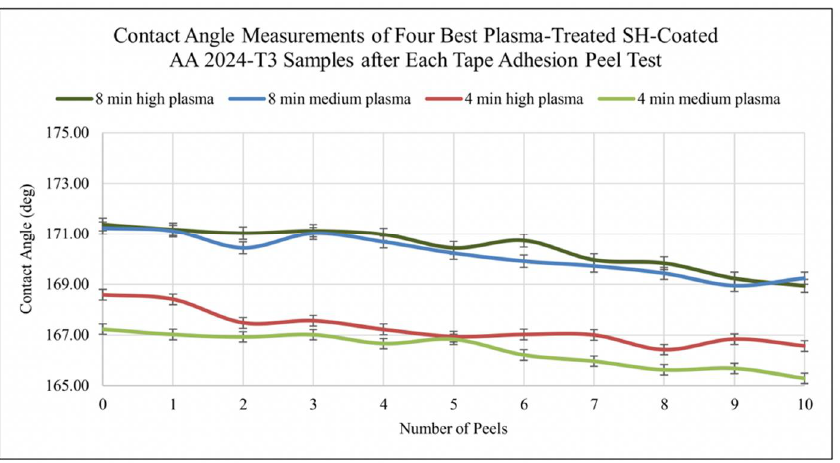
Figure 8. The contact angle after tape adhesion peel test. Reprinted with permission from Ref [57].